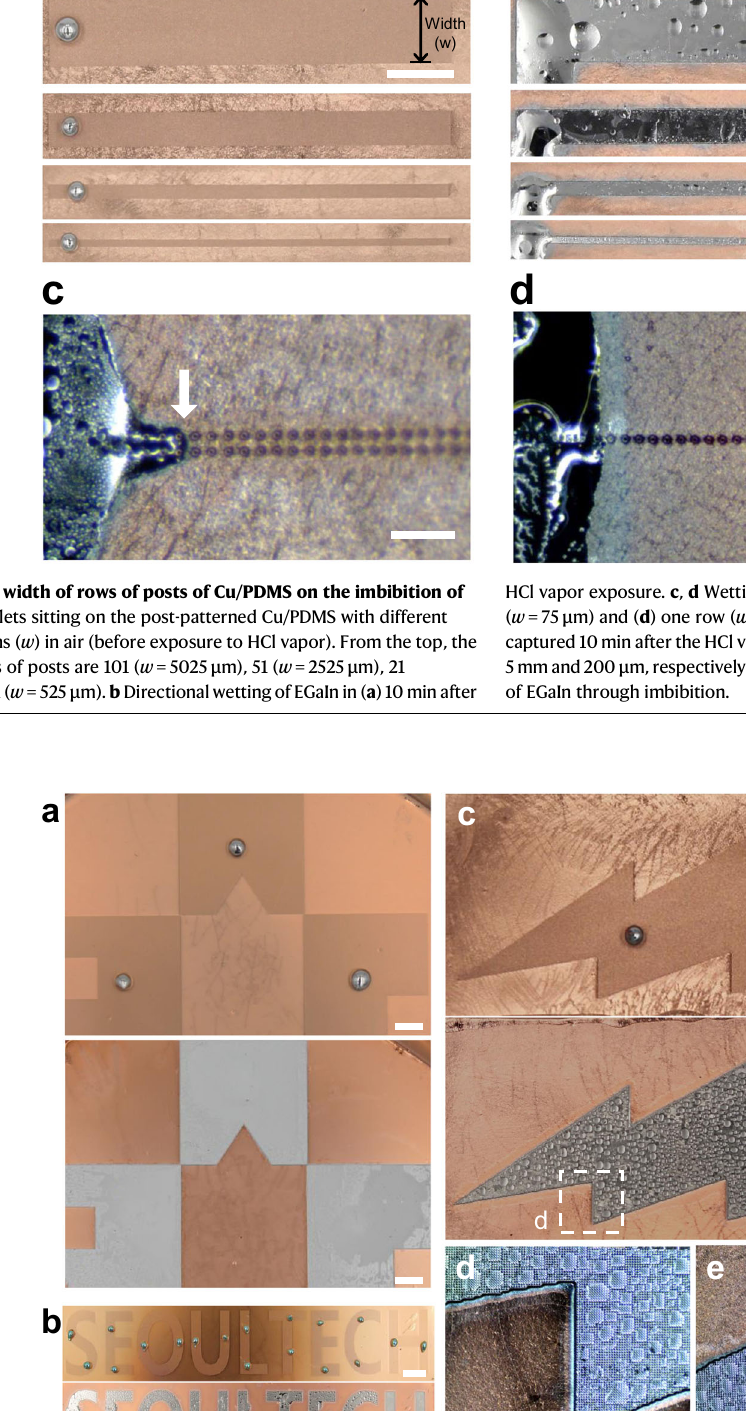
Nature Communications| (2022)